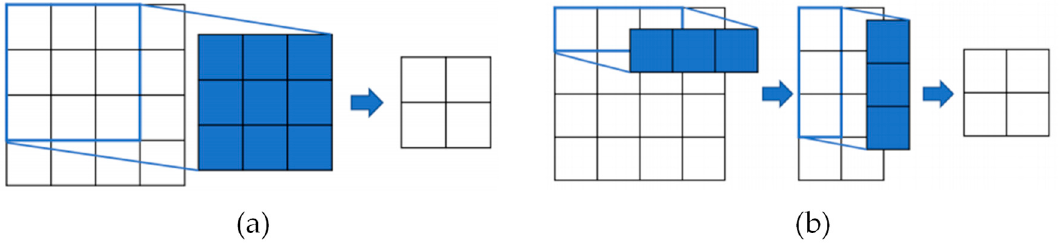
Figure 3. Comparison of a conventional and an asymmetric convolution. ( a ) General conventional convolution operation and ( b ) asymmetric convolution operation.